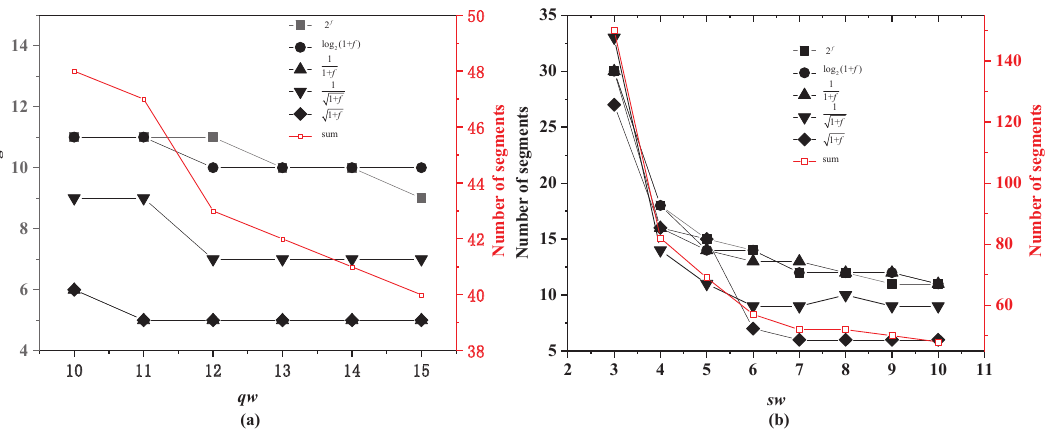
Figure 5. ( a ) Numbers of segments obtained with different qw settings by the segmentor proposed in [30]. ( b ) Numbers of segments obtained with different sw settings by the proposed segmentor.